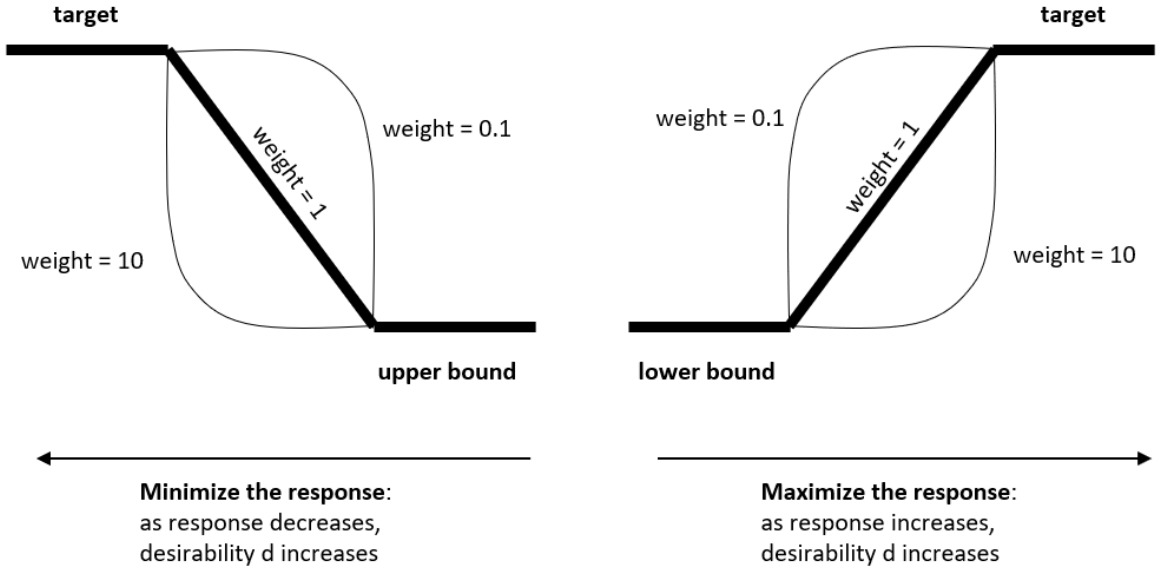
Figure 4. Desirability functions when minimizing (left) and maximizing (right) the response. The composite desirability function D is computed using the formula shown in Equation (4).